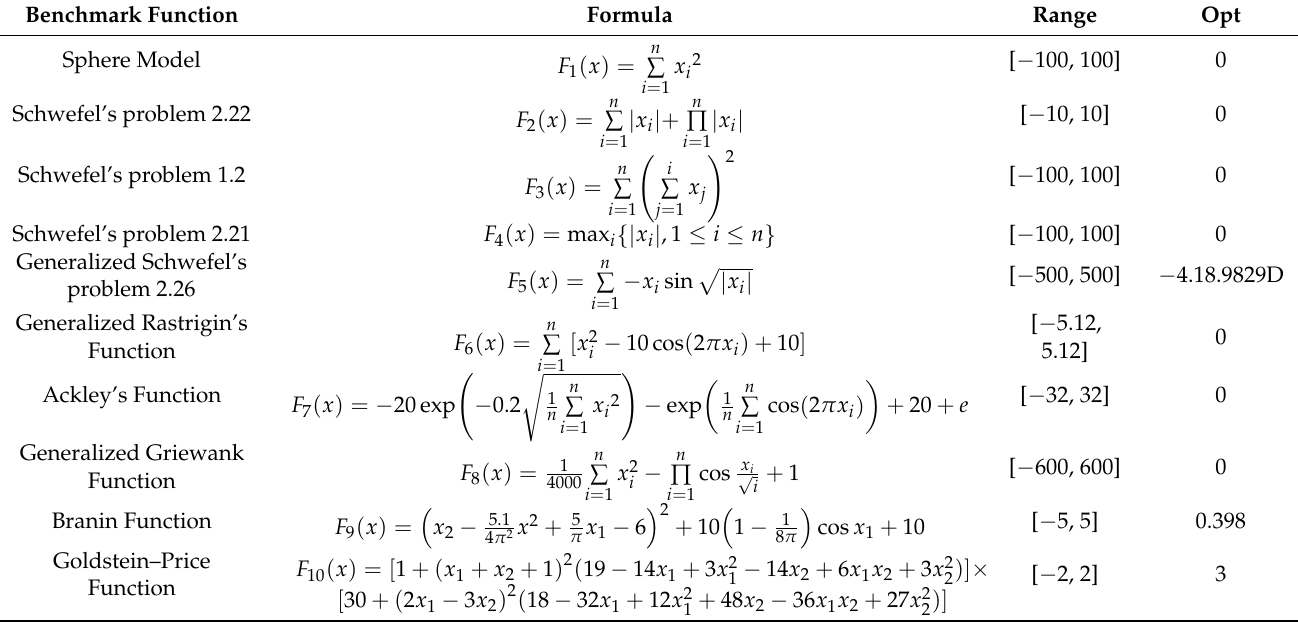
Table 1. Information on benchmark functions.